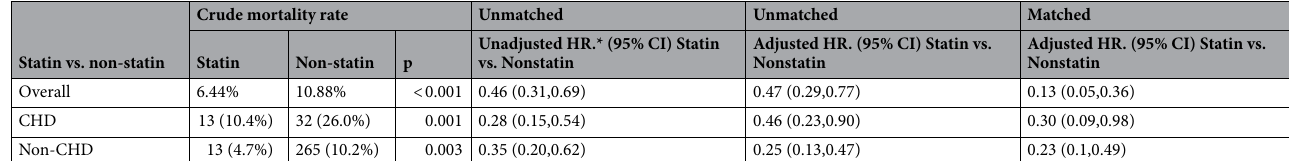
Table 2. In-Hospital mortality in CHD and Non-CHD patients before and after the PSM. *HR, the hazard ratio of in-hospital mortality between statin and non-statin